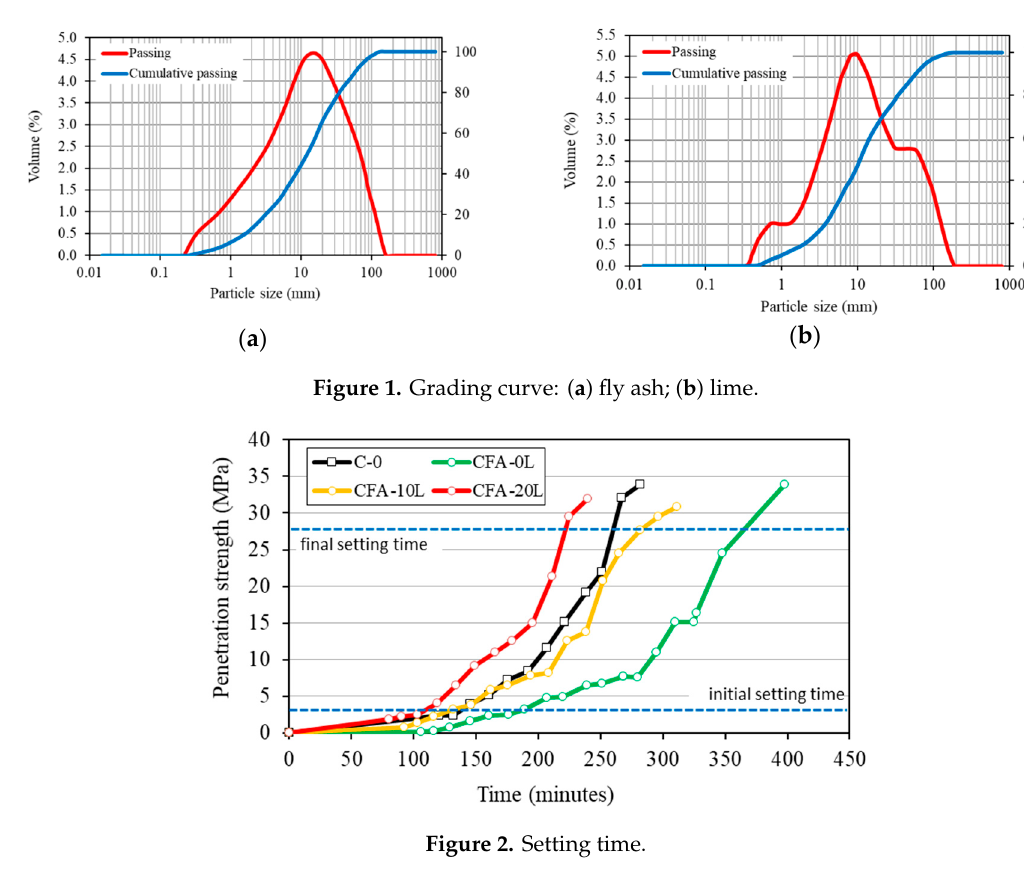
Table 3. Chemical composition of lime, wt % (by X-ray